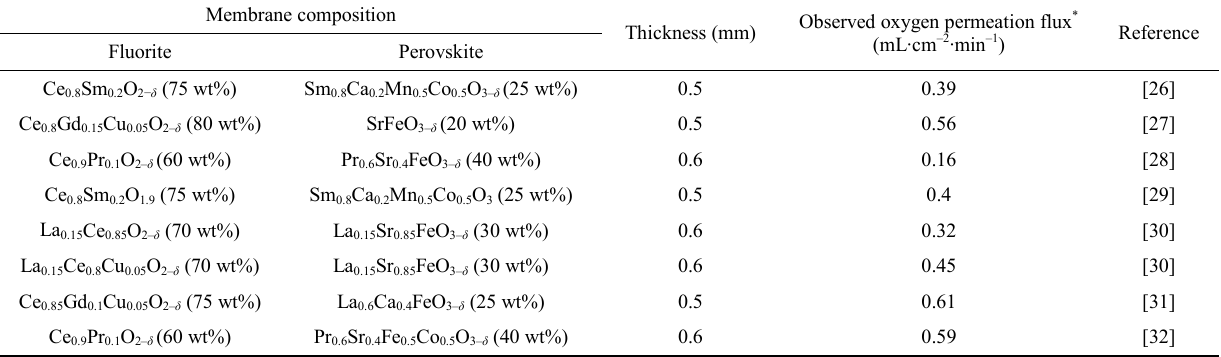
Fig. 1 Transport mechanism for simultaneous CO 2 and O 2 species that involves three different pathways: (a) perm-selective transport of CO 2 based on the oxygen ionic conduction properties of ceramic phases, and (b) perm-selective transport of oxygen and simultaneous transport of CO 2 /O 2 due to the mixed electronic–ionic conduction properties of the perovskite phase. Table 1 Composition and oxygen permeation features of dense membranes made of fluorite and perovskite